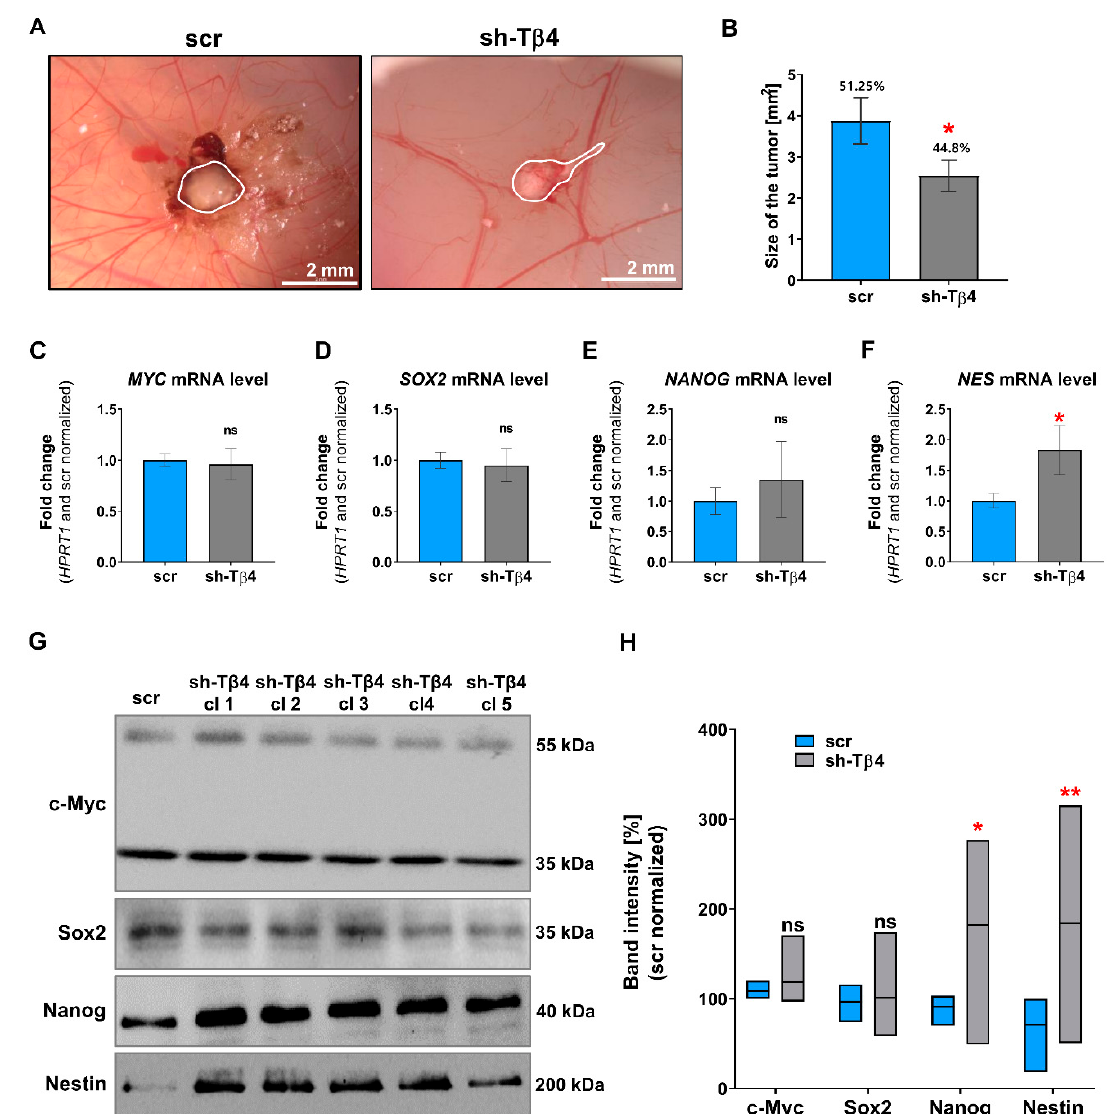
Figure 3. Evaluation of tumorigenic potential and level of stemness markers for the cells with lowered T β 4 level. ( A , B ) The chorioallantoic membrane (CAM) model was used to estimate in vivo tumor formation by scr and sh-T β 4 cells. ( A ) Representative microscopic images. Tumors were outlined with a white line. ( B ) Quantitative analysis of tumors and their size. For the sake of the estimation of cells’ ability to form tumors, we engrafted the cells on 33 and 38 embryos in the case of scr and sh-T β 4 cells, respectively. To evaluate the size of tumors, 17 tumors for both types of clones were measured. The graph indicates the mean ± SEM. The results presented separately for every clone are shown in Supplementary Figure S2. ( C – H ). Analysis of the expression of stemness-related markers (c-Myc, Sox2, Nanog, Nestin) in scr and shT β 4 cells ( n = 3). ( C – F ) qPCR analysis of MYC , SOX2 , NANOG , and NES expression ( n = 3). The HPRT1 gene was used for the normalization. The graphs indicate the mean ± SD. The results presented separately for every clone are shown in Supplementary Figure S3. ( G ) Representative immunoblots of tested stemness-related markers. Thirty micrograms of protein were loaded on every lane. Membranes were probed for chosen stemness marker proteins: c-Myc, Sox2, Nanog, and Nestin. Corresponding Ponceau S membrane stainings are shown in Supplementary Figure S4A. ( H ) Densitometric analysis of c-Myc, Sox2, Nanog, and Nestin Western blots ( n = 3). The significance level was set at * p < 0.05, ** p < 0.01. Graphs indicate average-max-min values. The results presented separately for every clone are shown in Supplementary Figure S4B.